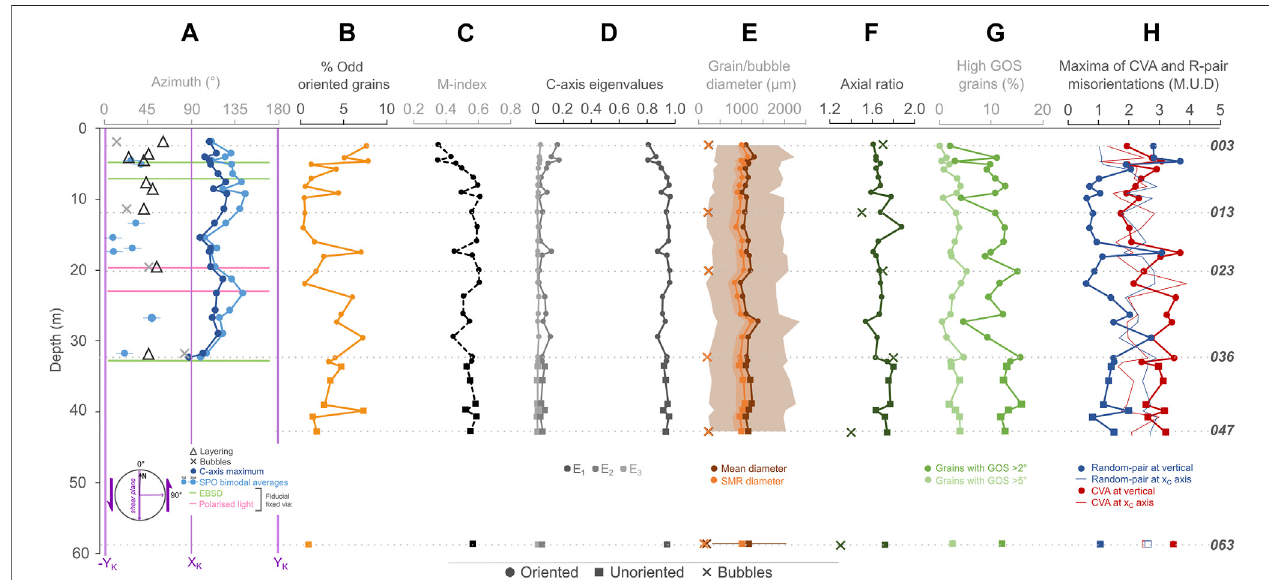
FIGURE 12 | (A-D) Quantitative CPO strength and orientation, (E) grain size (shaded area representing 1 standard deviation), (F-H) shape and orientation parameters vs depth. ′ Odd ′ grains are those oriented differently to the main cluster (see Sections 4.3 , 4.6 ). The plot of c -axis maximum (the angle of the principal eigenvalue E1 relative to the fl ow direction 0/180 ° , grain long axis, bubble long axis and layer orientations are presented in the kinematic reference frame, where the x K axis is perpendicular to fl ow.